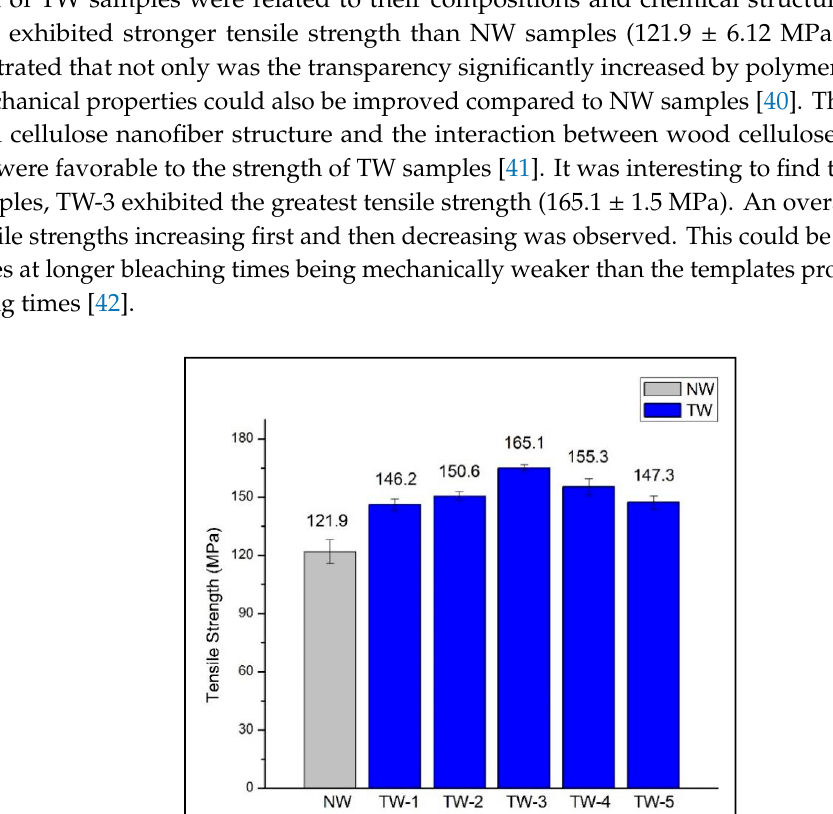
Figure 6. Tensile strength of natural wood (NW) and transparent wood (TW) samples. 279